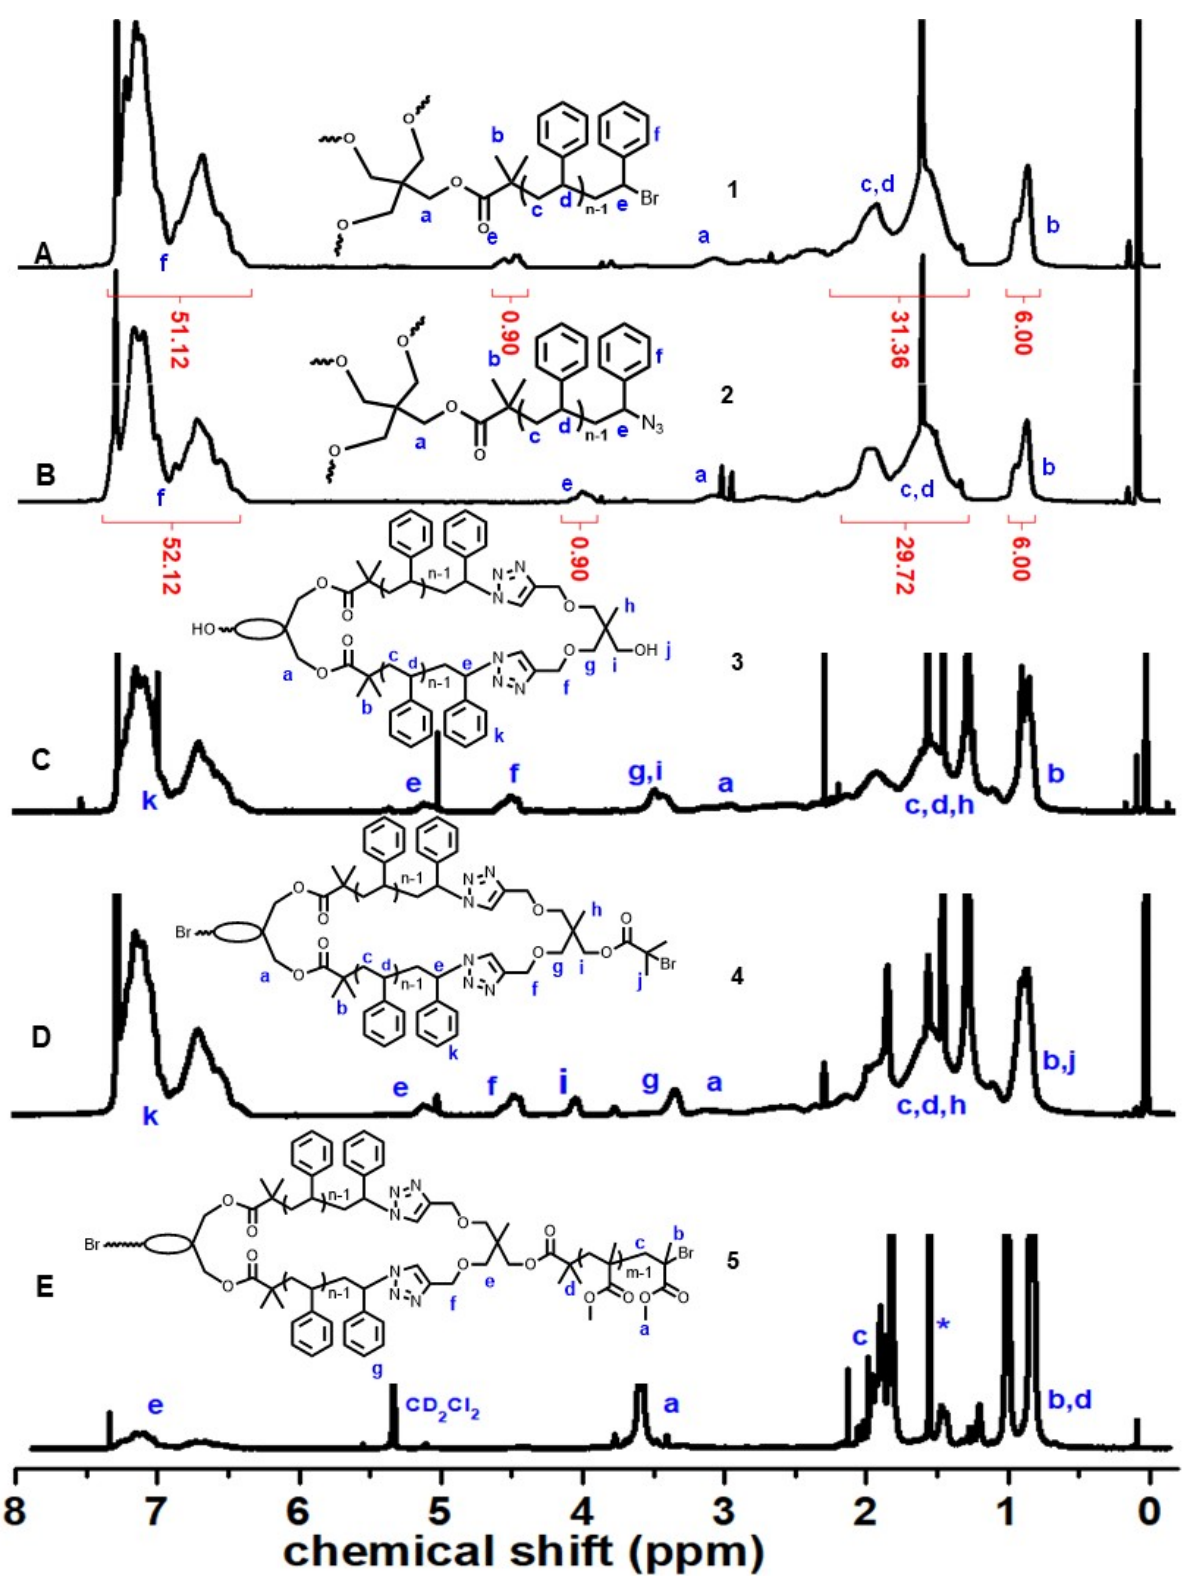
Figure 2. 1 H NMR spectra of ( A ) tetra-arm PS-Br, ( B ) tetra-arm PS-N 3 , ( C ) spirocyclic PS, ( D ) spiro- cyclic macroinitiator, and ( E ) PMMA- b -cPS- b -PMMA triblock copolymer (* indicating H 2 O peak).